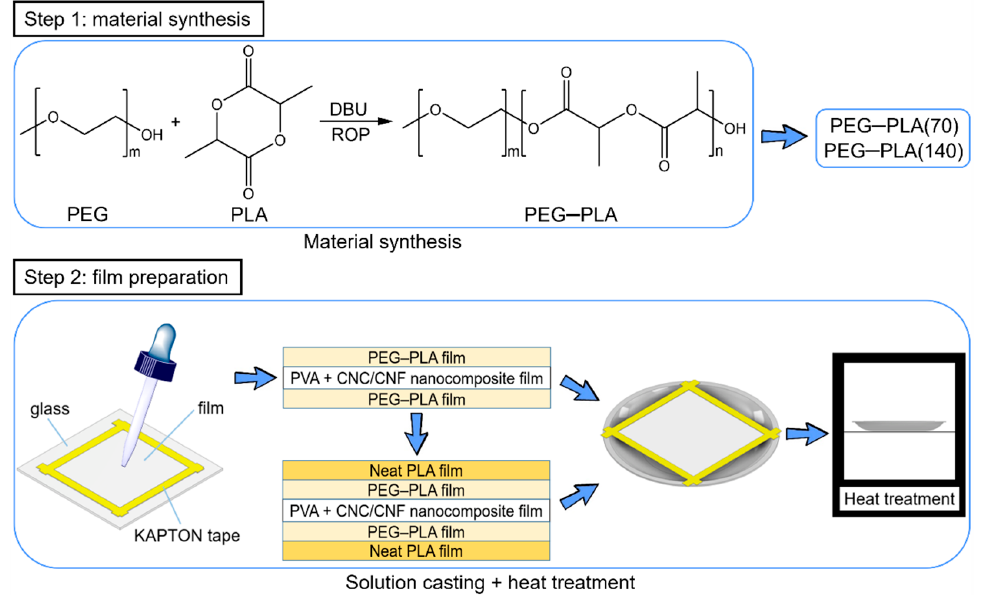
Figure 2. Preparation of hydrophobic materials and sandwich-structured PVA-based hydrophobic composite films.